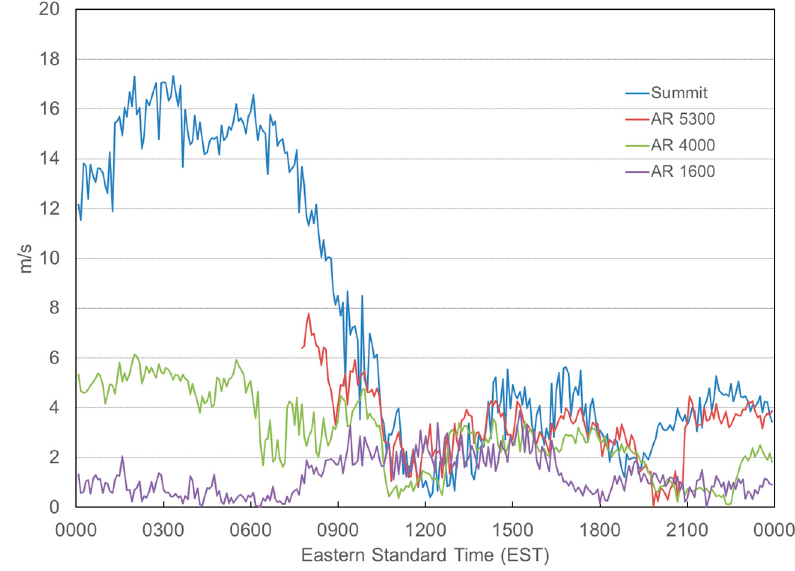
Figure 8. Time series of wind speed at the summit, AR5300, AR4000 and AR1600 mesonet stations on 19 August